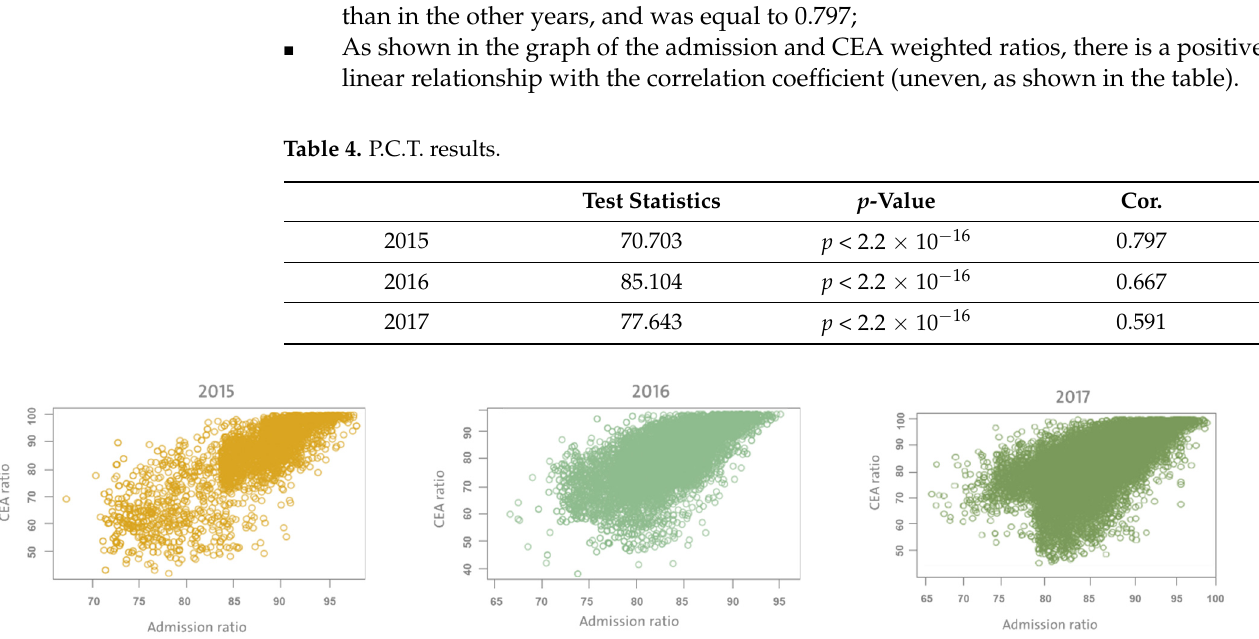
Test Statistics